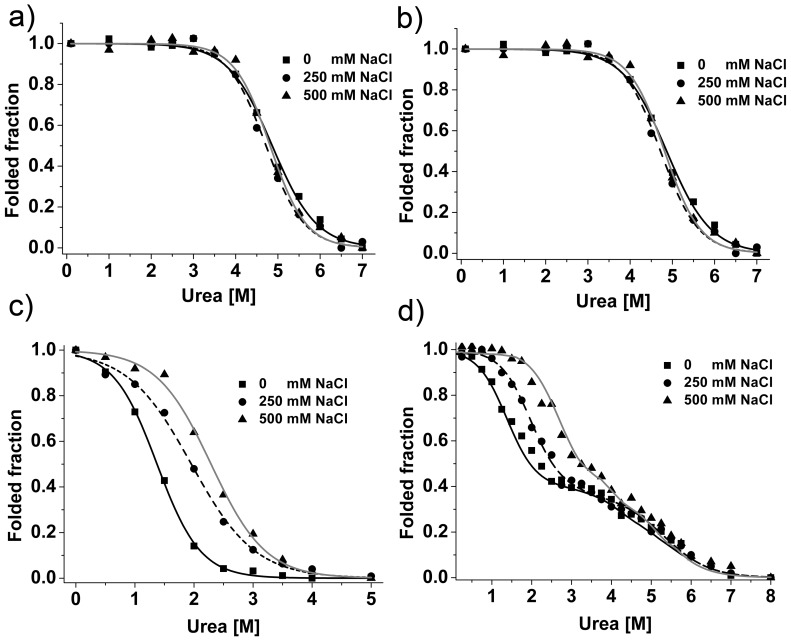
Urea-induced denaturation of MiSp fragments under different NaCl concentrations monitored by CD.a) CTDMi; b) LK-CTDMi; c) RPMi; d) RP-LK-CTDMi. The lines represent the fitting curves. All the data were normalized.